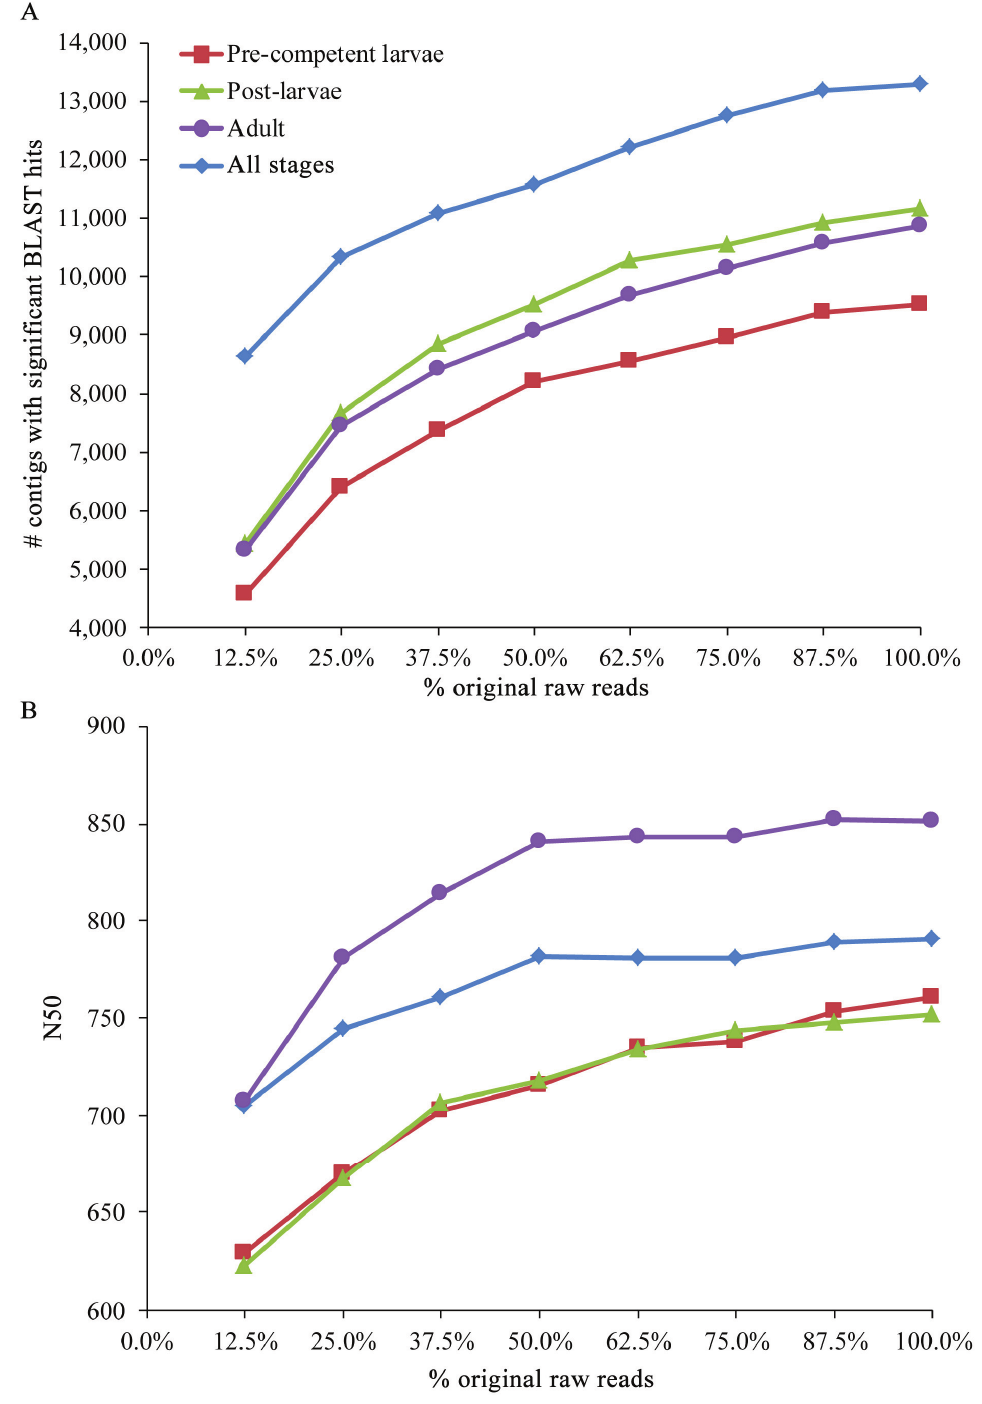
Figure 2. Assessing the coverage of the transcriptomes for the four life cycle/all stages with random subsampling of the original raw reads. ( A ) Changes in the number of contigs with significant BLAST hits as sample size is increased by an increment of 12.5% from 12.5% to 100% of the original raw reads; ( B ) Changes in N50 for these same samples of the original raw reads. In Riesgo et al. [33], subsamples of increasing size were generated by adding an increment of 5 million more reads to the previous subset. Thus, our subsamples are more independent than theirs in that each represents its own separate draw of the original raw reads for a